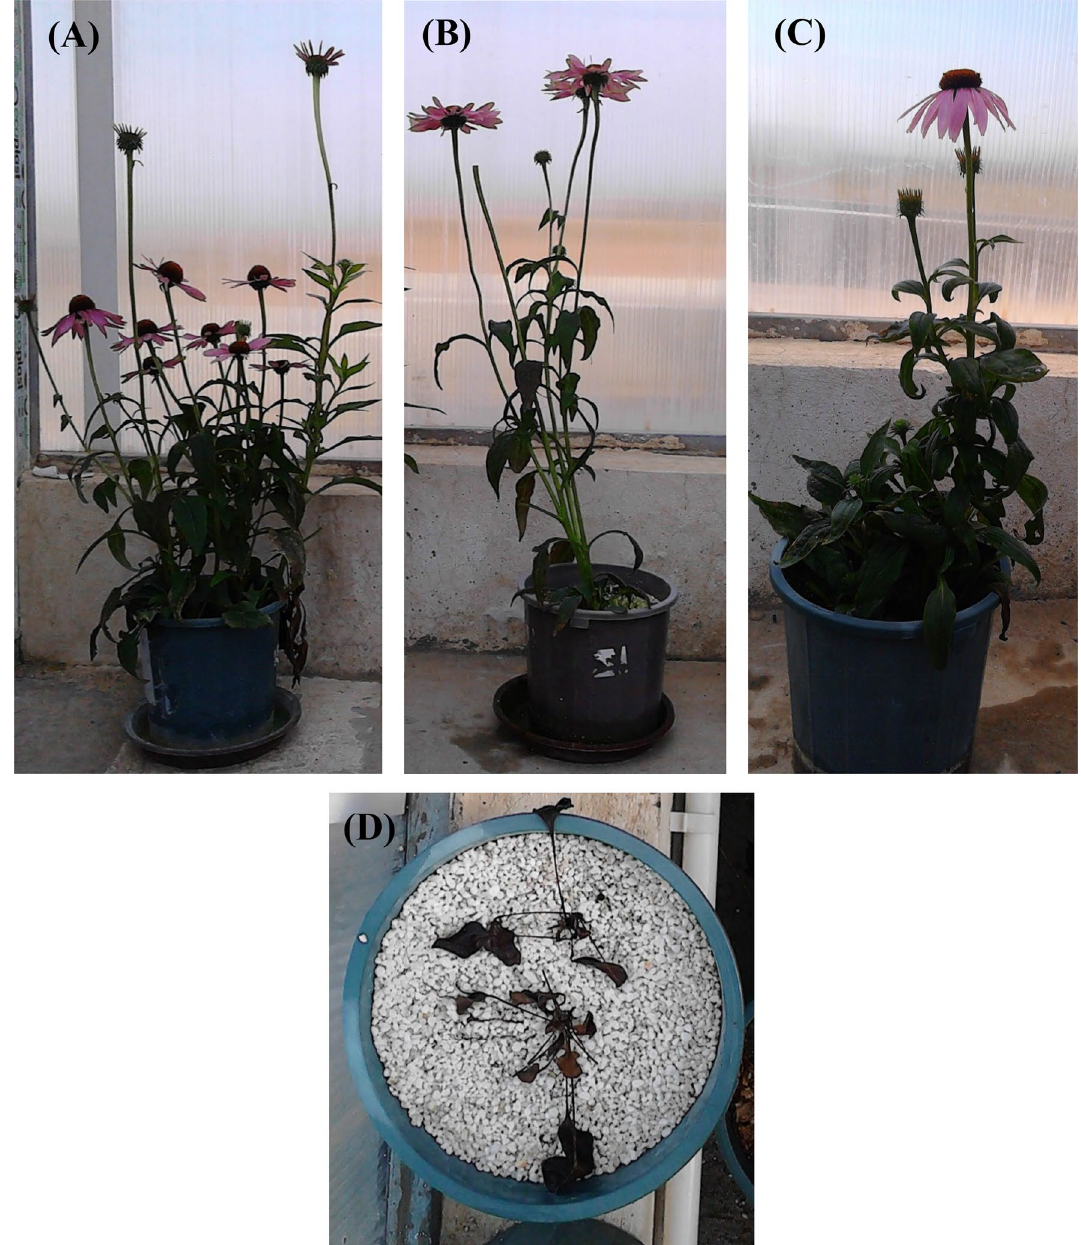
Figure 1. Echinacea purpurea grown in ( A ) 50% peat moss + 50% perlite (< 0.5 mm), ( B ) 30% peat moss + 70% perlite (< 0.5 mm), ( C ) 100% peat moss, and ( D ) 100% perlite (> 2 mm) culture media, just at 90:10 NO 3− /NH 4+ ratio (all photos were taken by F.